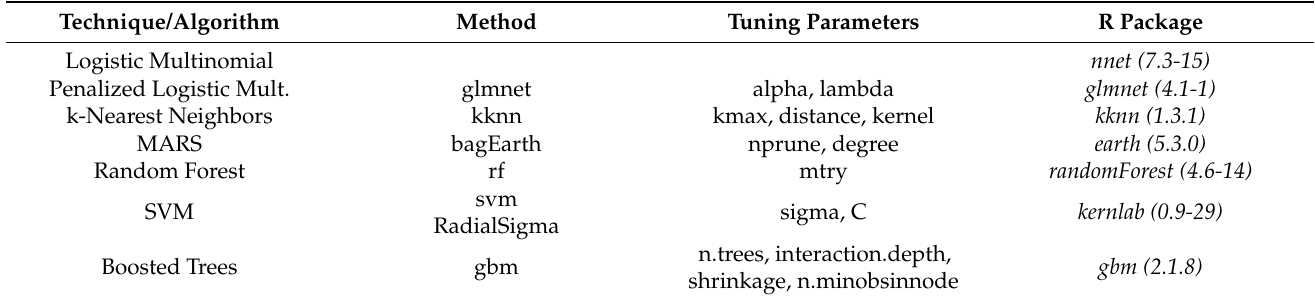
Table 1. Algorithms and statistical techniques used for classification of the catastrophic rate.